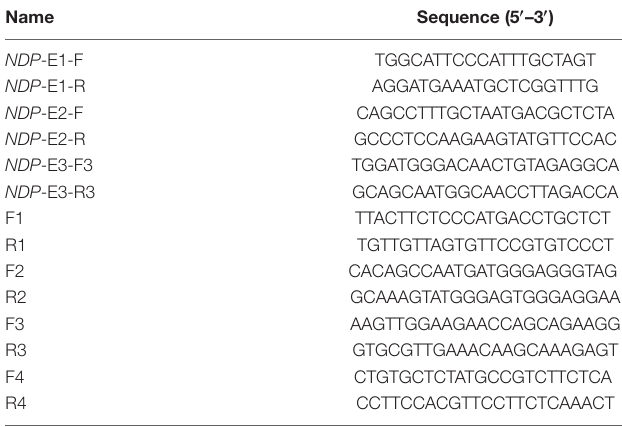
TABLE 1 | Primers of